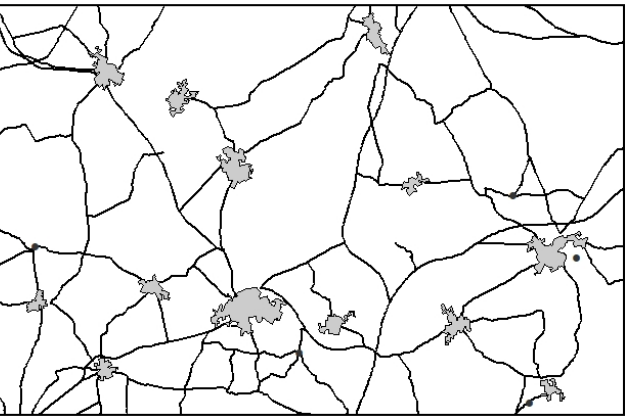
Figure 10. Initial road network and built areas (no generalization is applied) at scale 1: 500,000.